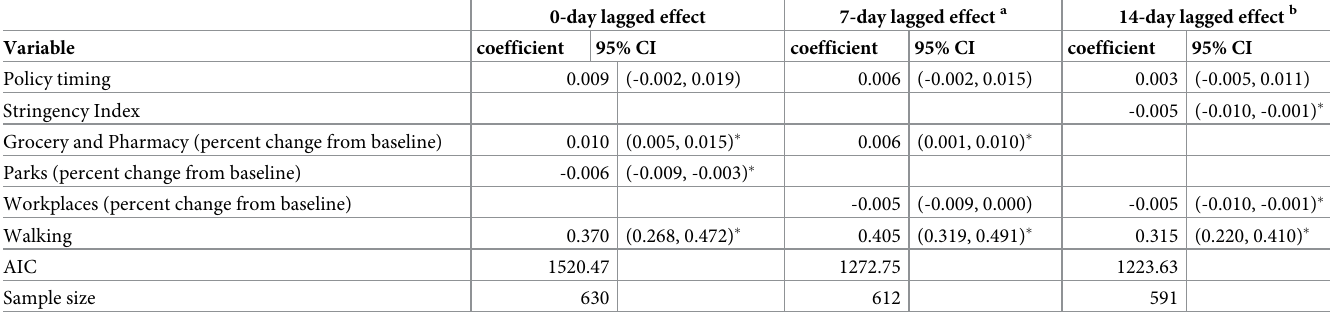
Table 3. Estimated effects on effective reproduction